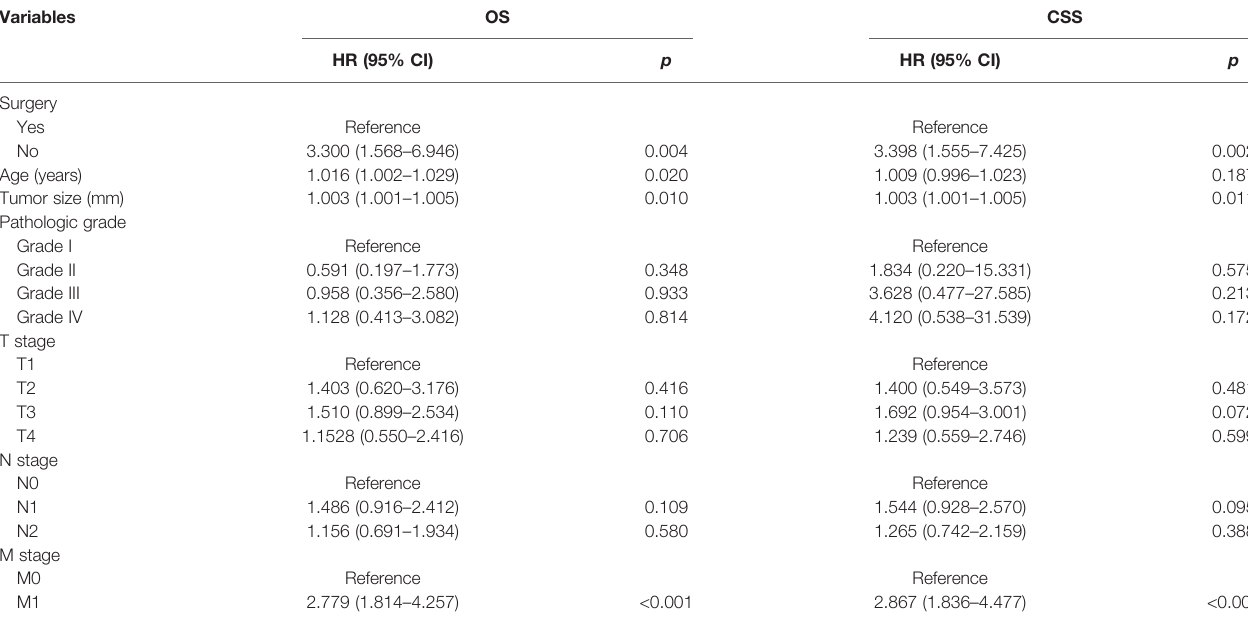
TABLE 3 | DAG-guided multivariable Cox regression model analysis of causal effect of surgery on OS and CSS.